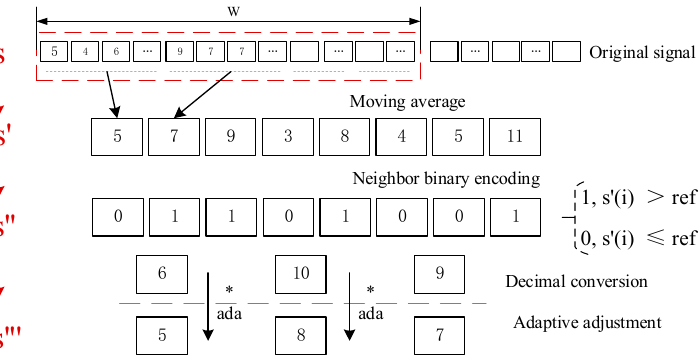
Figure 5. The coding flowchart of adaptive MNBP (AMNBP).